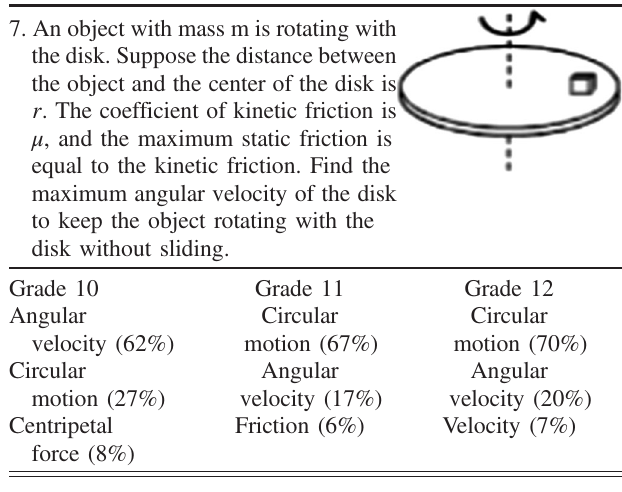
TABLE II. The percentage of the top 3 categories for Q7 created by the students in different grades.